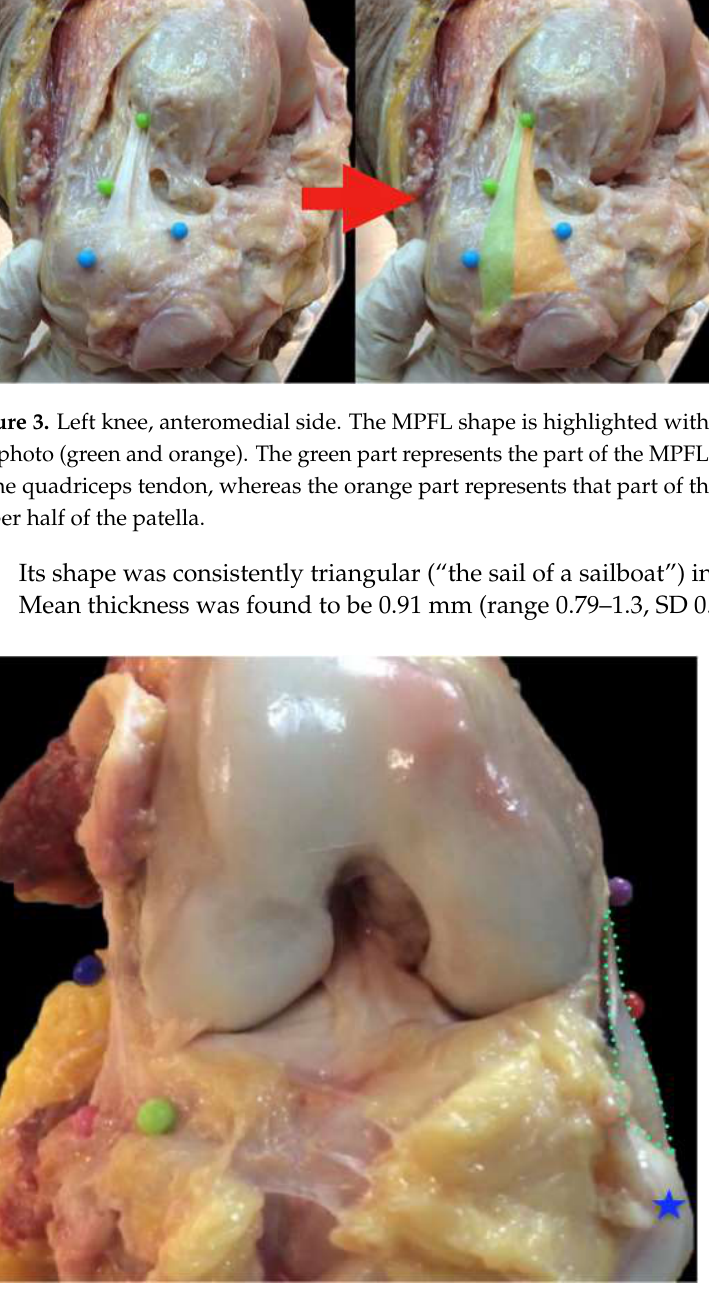
Figure 4. Right knee, anterior side. The patella (blue star) has been reflected. The MPFL (and its width) is depicted inside the green dotted line.